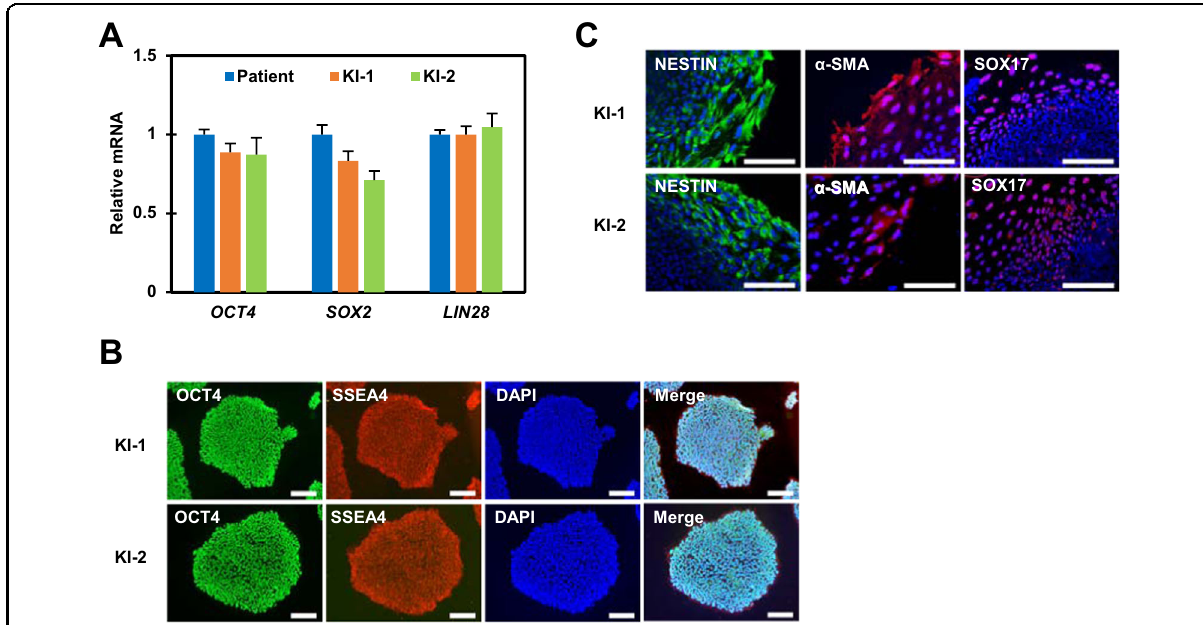
Fig. 2 Pluripotency analysis of gene-corrected iPSC lines. a Quantitative real-time PCR (qPCR) analysis of OCT4 , SOX2 , and LIN28 in parental patient cells and gene-corrected iPSC lines. GAPDH was used to normalize gene expression. b Immuno fl uorescence staining to indicate expression of the pluripotency markers OCT4 (green) and SSEA4 (red) of gene-corrected iPSC clones. Nuclei were labeled with 4 ′ ,6-diamidino-2-phenylindole (DAPI; blue) (scale bar, 200 μ m). c Immuno fl uorescence staining shows the expression of marker proteins, representing the ectoderm (NESTIN, green), the mesoderm ( α -SMA, red), and the endotherm (SOX17, red). Nuclei were labeled with DAPI (blue) (scale bar, 200 μ